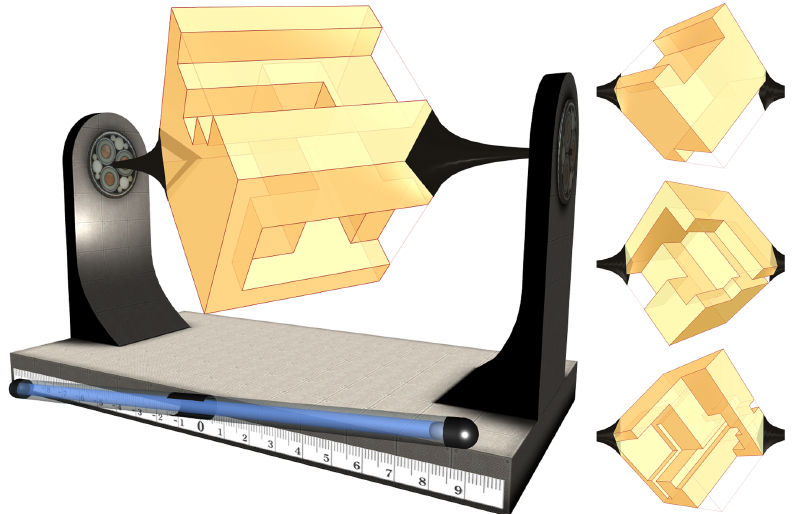
Figure 10. A snapshot of the Euler’s grill ( left ) and examples of different topological complexities ( right